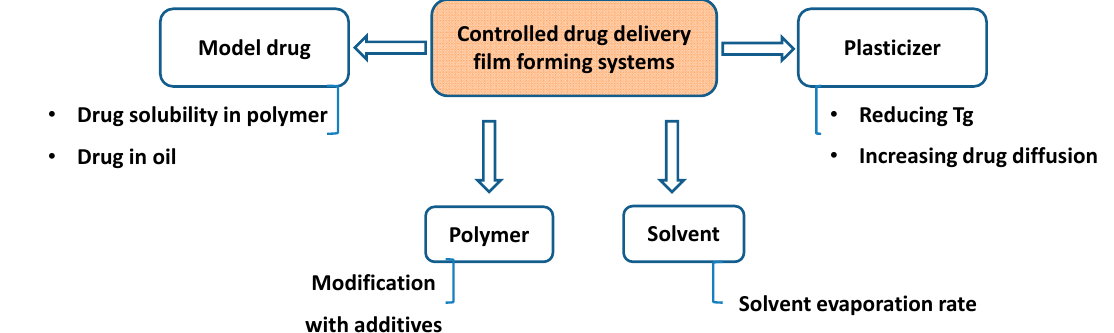
Figure 3. Illustration of factors in designing controlled drug delivery FFSs.